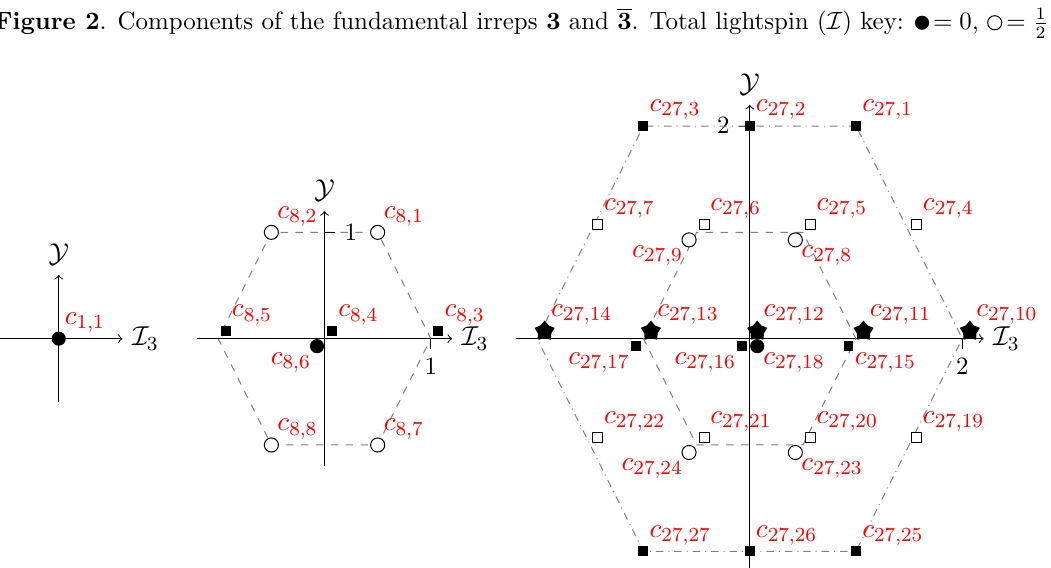
Figure 2 . Components of the fundamental irreps 3 and 3 . Total lightspin ( I ) key: = 0 , = 1